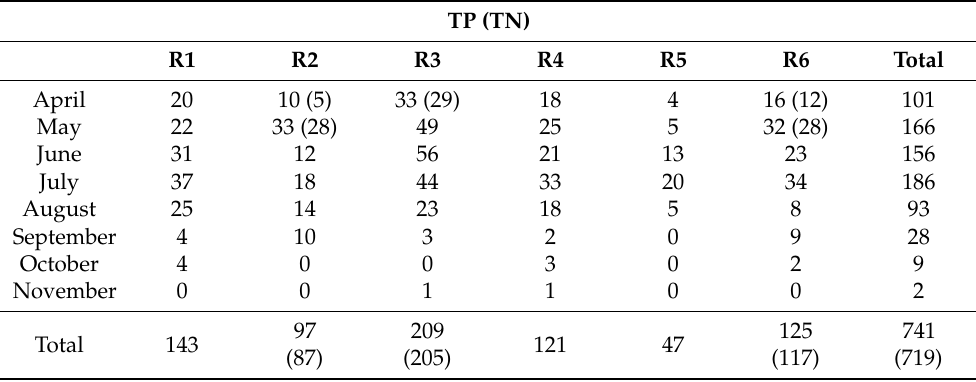
Table 1. The distribution of the match-ups for total phosphorus (TP) and nitrogen (TN) between study regions (R1–R6) and months (April–November 2016–2021). In the case that there was a different number of match ups for TN, it is shown in parentheses.